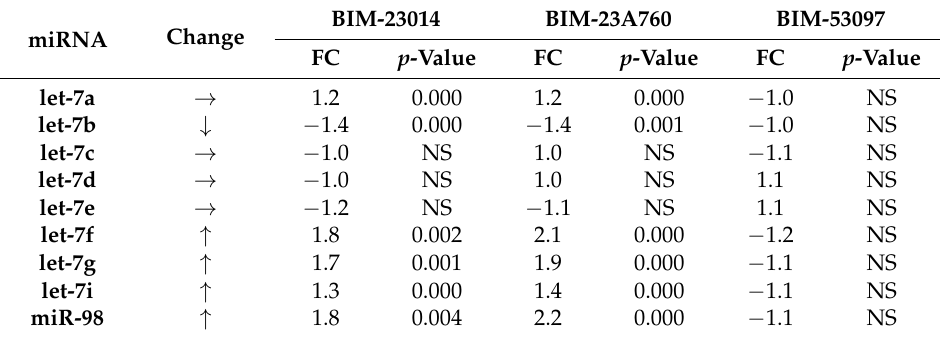
Table 5. Differentially regulated let-7 family members based on SSA